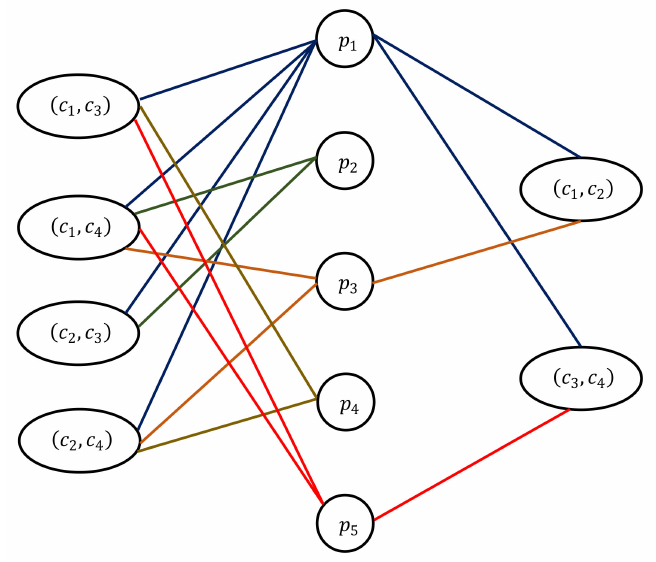
Figure 1. Graph representation of the α , β - k -FSP for the example given in Tables 1 and 2.